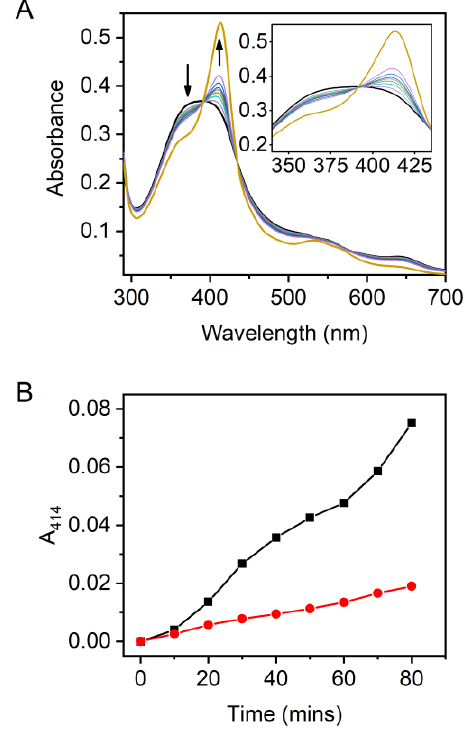
Figure 5. An O 2 -dependent heme binding to HupZ. ( A ) Aerobic reconstitution of 5 μM HupZ with 5 μM heme over 4 h with the 4 h spectrum drawn in orange. The arrows indicate the trend of change in the spectra ( B ) Difference spectra monitoring 414 nm absorbance plotted against time for aerobic (black squares) and anaerobic (red circles) plotted against time.